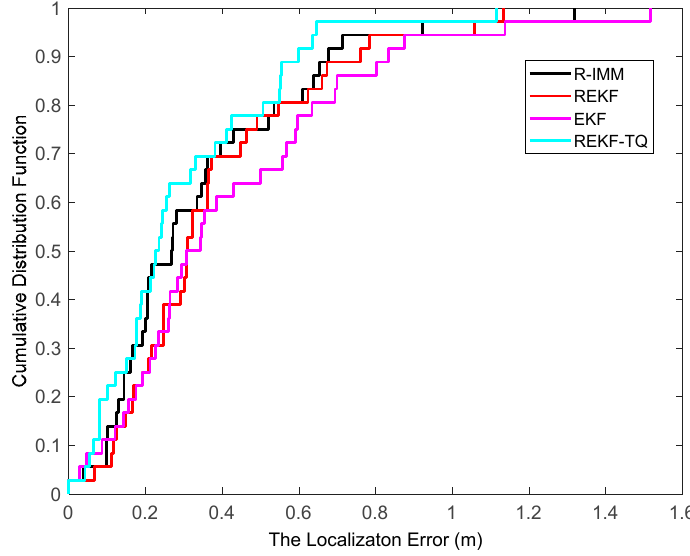
Figure 17. The localization error CDF.